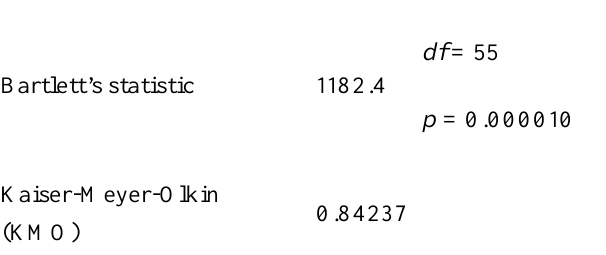
Adequacy of the Correlation Matrix